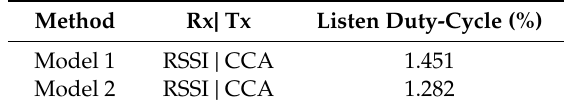
Table 7. Comparison of models of 1 and 2 in terms of percentage of listen